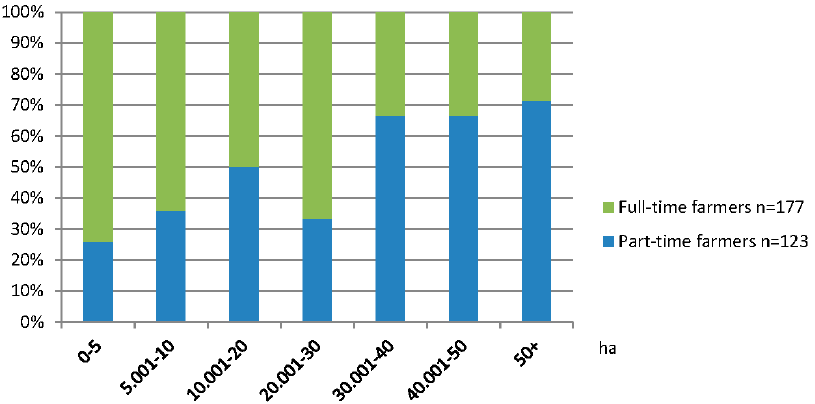
Figure 3. Percentage of full-time and part-time farmers, by farm size, in Mchinji, Lilongwe and Kasungu ( N = 300). Source: Authors’ medium-scale farm survey in the Mchinji, Kasungu and Lilongwe Districts undertaken by LUANAR, UP, and MSU (2014–2015). Note: There is a statistically significant difference in the distribution by land size between full-time and part-time farmers at a 5% level of significance (Anova p -value 0.021747).